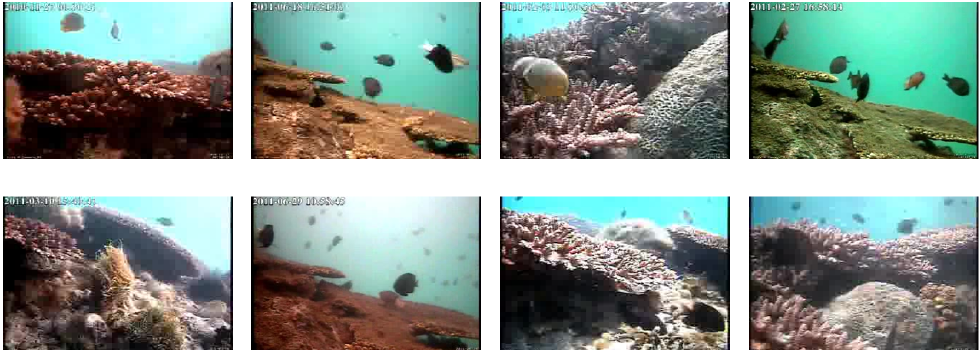
Figure 1. Examples of underwater images from different videos of the LifeClef 2015 Fish dataset. These examples illustrate the high variation in unconstrained underwater environments, such as complex, crowded and dynamic backgrounds and luminosity